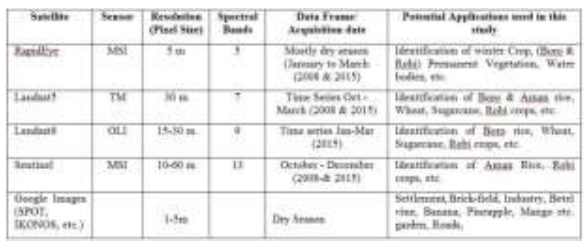
Table-1: Satellite images and its characteristics used in the study